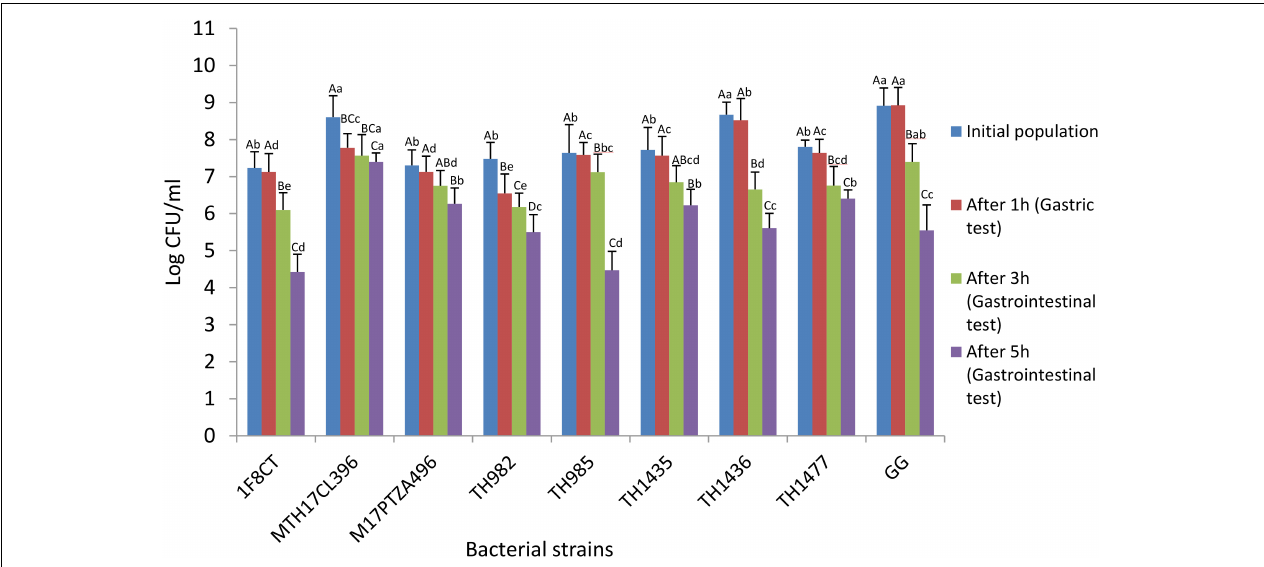
FIGURE 1 | Survival of S. thermophilus strains and Lb. rhamnosus GG during exposure to in vitro simulated gastrointestinal conditions. Results are expressed as the mean ± SD ( n = 3). Upper-case letters indicate significant differences among treatments and lower-case letters indicate significant differences among the strains ( P <